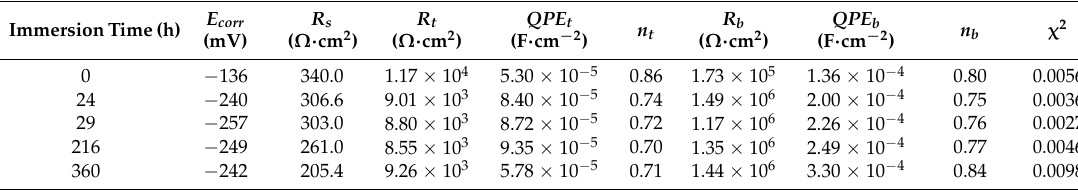
Table 3. Electrical equivalent circuit parameters of the Ti_NT org sample.